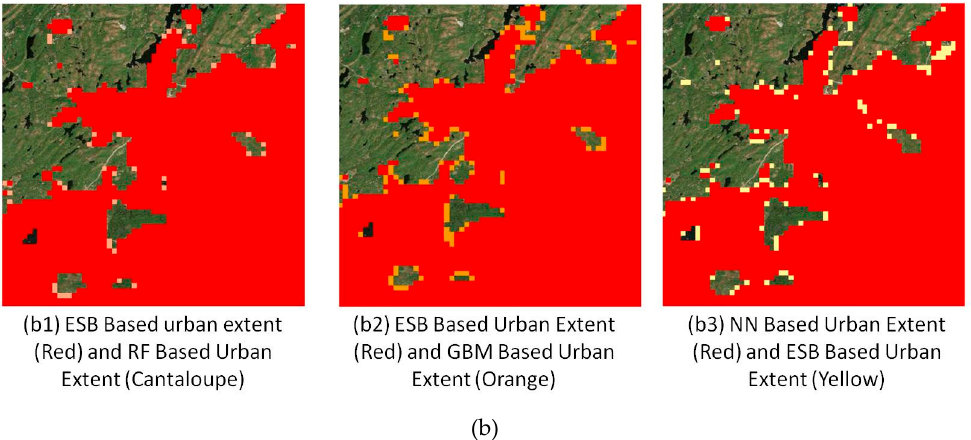
Figure 6. Urban extent maps generated by Random Forest (RF), gradient boosting machine (GBM), neural network (NN), and their ensemble (ESB) for CONUS 2015: ( a ) whole urban extent maps generated by the four machine learning algorithms ( a1,a2,a3,a4 ), ( b ) zoom-in detailed comparison of the four urban extent maps ( b1,b2,b3 ).